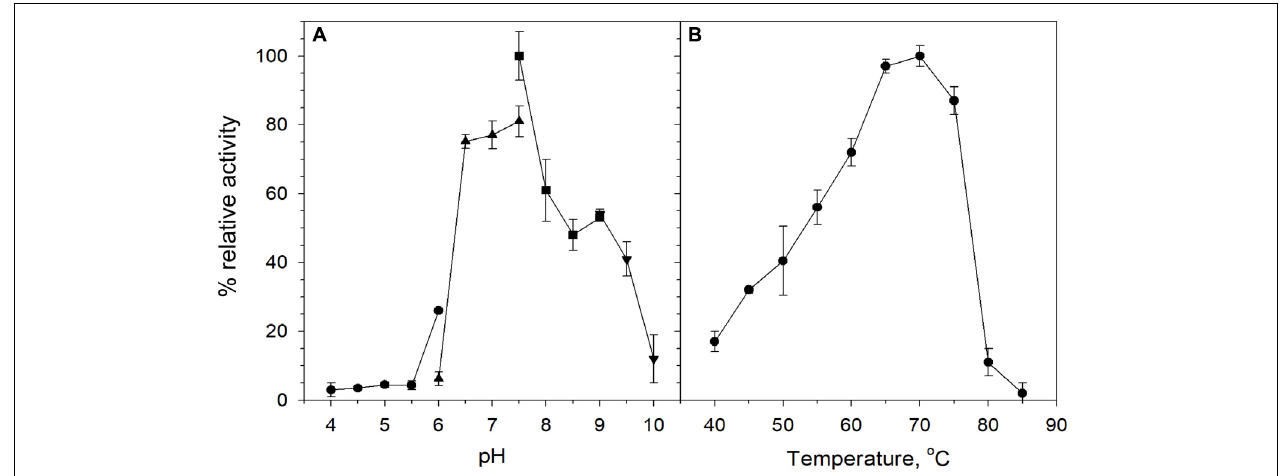
FIGURE 3 | Effect of pH and temperature on the activity of XynDZ5. (A) Effect of pH on XynDZ5 activity. For the various pH values ranging from 4 to 10, the following buffer systems were used: acetate ( • ), phosphate ( (cid:78) ), Tris–HCl ( (cid:4) ), glycine-NaOH ( (cid:72) ). (B) Effect of temperature on XynDZ5 activity. Enzyme activity was measured at temperatures ranging from 40 to 85 ◦ C and pH 7.5 in the standard assay. The reported values correspond to the mean value from three independent experiments performed in triplicate ± one standard deviation from the mean value.